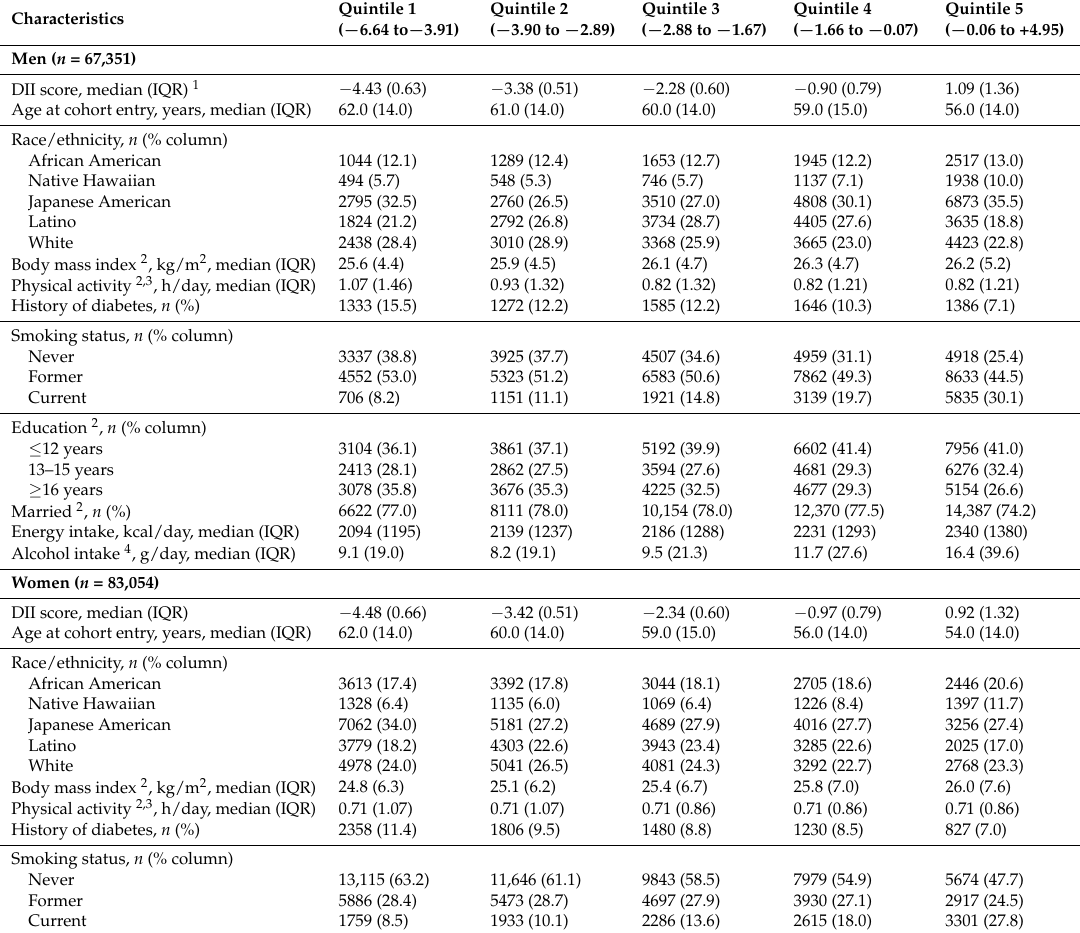
Table 1. Baseline characteristics of participants ( n = 150,405) in the Multiethnic Cohort by quintiles of Dietary Inflammatory Index (DII)